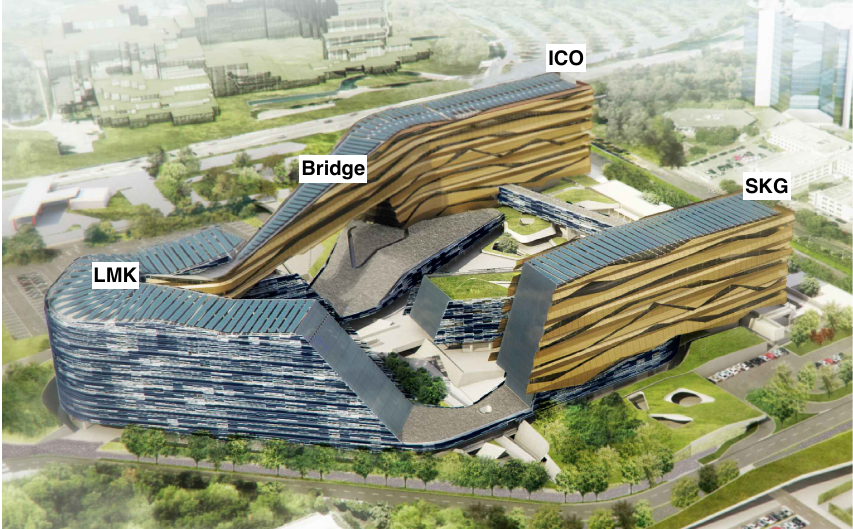
Figure 1. Render of the ENI Head Office in